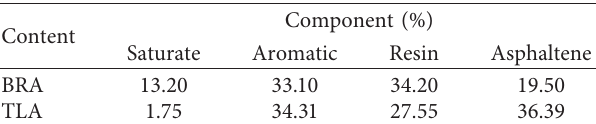
Table 3: Component of natural